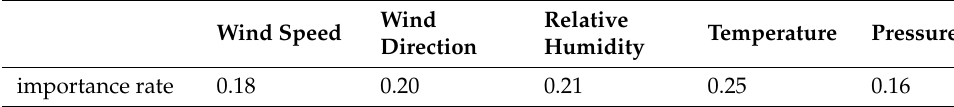
Table 4. Relative importance rate of meteorological factors on